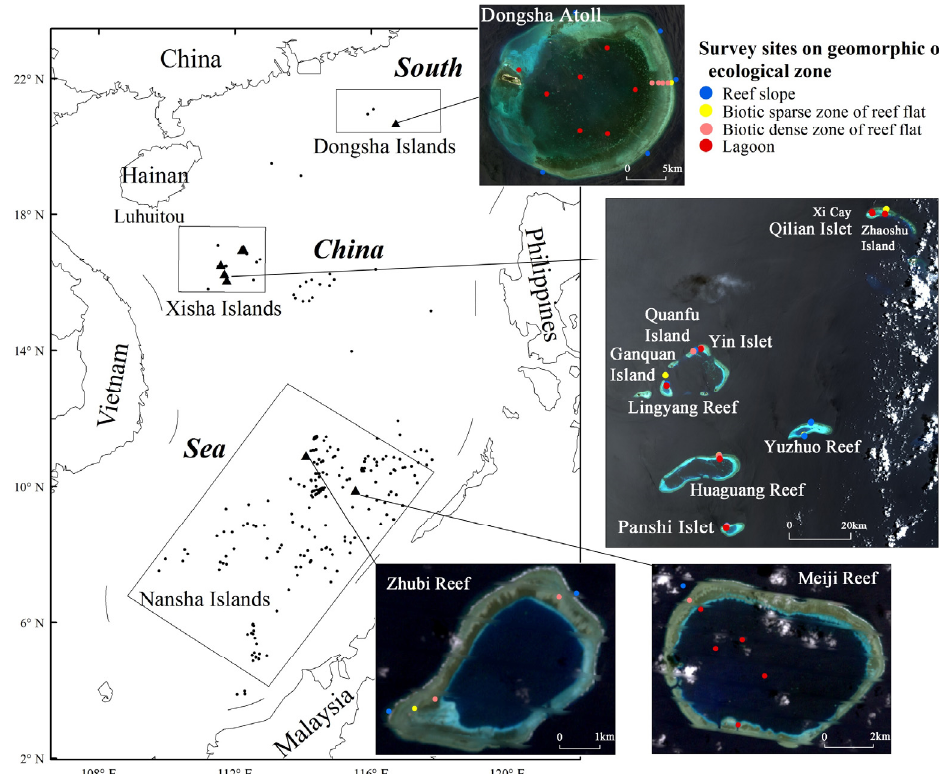
Figure 1. Location of field data sites in the Xisha Islands, South China Sea: Xi Cay and Zhaoshu Island of Qilian Islet, Yin Islet, Quanfu Island, Ganquan Island, Lingyang Reef, Huaguang Reef, Panshi Islet, Yuzhuo Reef; Dongsha Islands: Dongsha Atoll (derived from Decarlo et al., 2017 [34]; Tkachenko and Soong, 2017 [33]); Nansha Islands: Zhubi Reef and Meiji Reef (derived from Zhao et al., 2013 [35]). Blue dots represent the sites at the reef slope, gold dots represent the sites at the biotic sparse zone of the reef flat, pink dots represent the sites at the biotic dense zone of the reef flat, red dots represent the sites in the lagoon. The sites are overlaid on the Gaofen-1 moderate spatial resolution image (16 m × 16 m pixel size) acquired on 30 May 2014 in Xisha Islands and on 8 May 2015 in Dongsha atoll, as well on the Landsat ETM+ multi-spectral and pan fusion moderate spatial resolution images (15 m × 15 m pixel size) acquired on 17 February 2007 in Meiji Reef and on 8 February 2007 in Zhubi